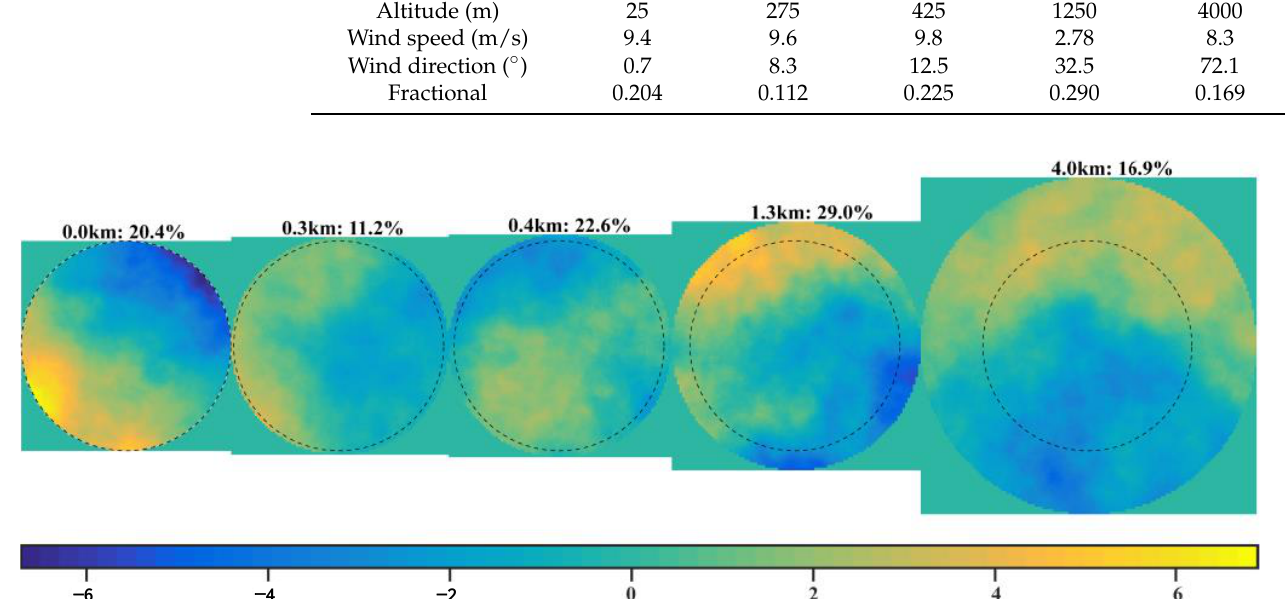
Figure 2. Five phase screens of different layers for the atmosphere with r 0 of 10 cm. The dashed circle line illustrates the diameter of the pupil.